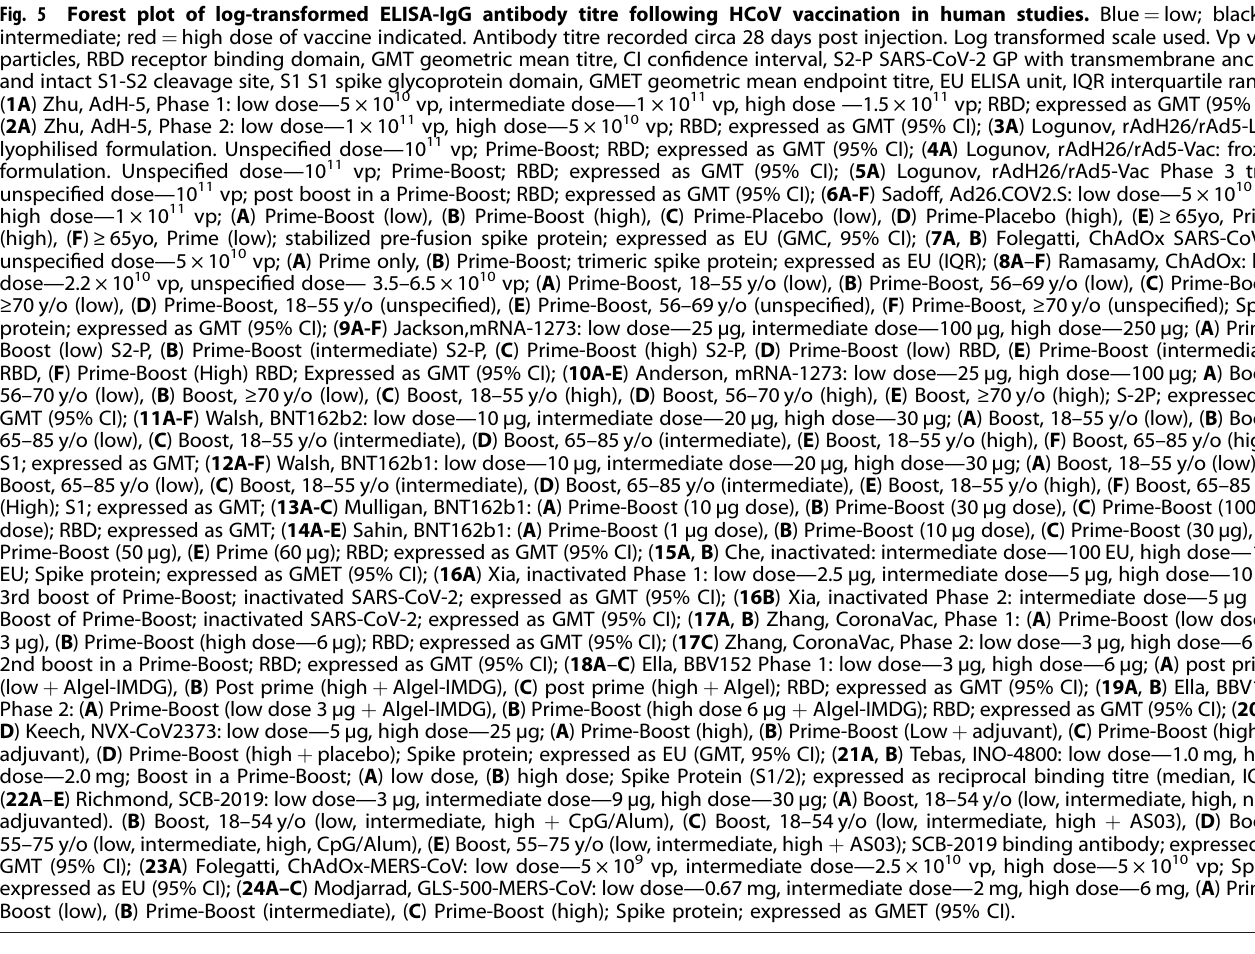
Fig. 5 Forest plot of log-transformed ELISA-IgG antibody titre following HCoV vaccination in human studies. Blue = low; black = intermediate; red = high dose of vaccine indicated. Antibody titre recorded circa 28 days post injection. Log transformed scale used. Vp viral particles, RBD receptor binding domain, GMT geometric mean titre, CI con fi dence interval, S2-P SARS-CoV-2 GP with transmembrane anchor and intact S1-S2 cleavage site, S1 S1 spike glycoprotein domain, GMET geometric mean endpoint titre, EU ELISA unit, IQR interquartile